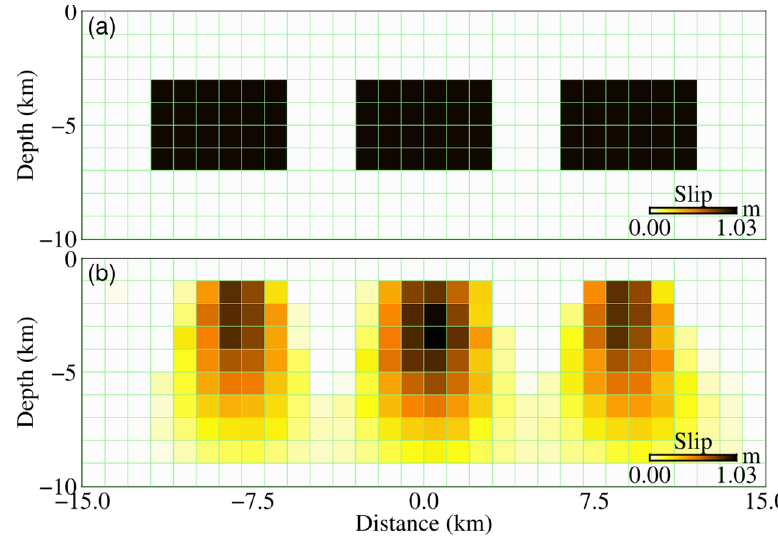
Figure 9. Checkerboard test. ( a ) The input model with three asperities, the slip magnitude for each asperity with 6 × 4 subfaults was assigned as 1 m. ( b ) The model recovered by the synthetic InSAR observations.